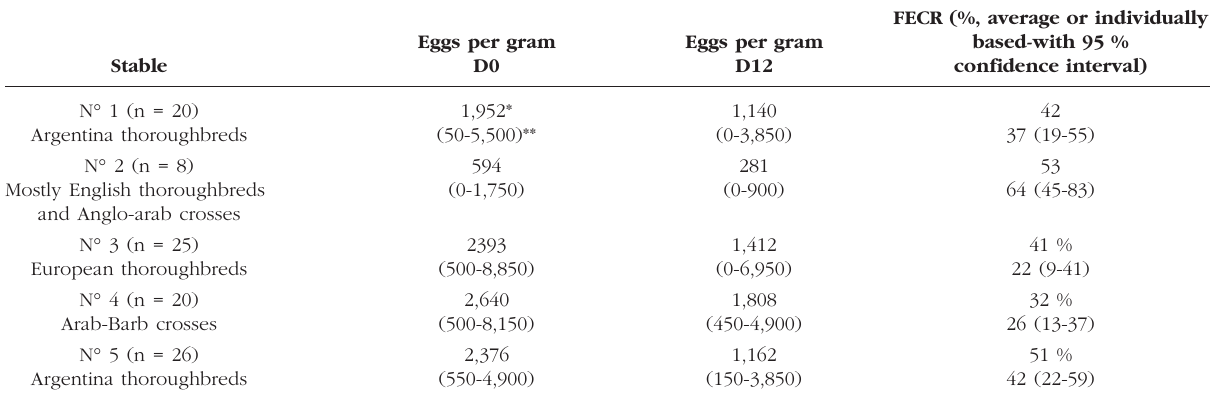
Table IV. – Faecal egg count reduction test after treatment (FECR based on D12, 12 days) in five stables of Raf-2 after thiabendazole treat- ment using a unique dose of 18.75 g per horse which corresponded to 26-55 mg/kg body weight depending on horse (1999).